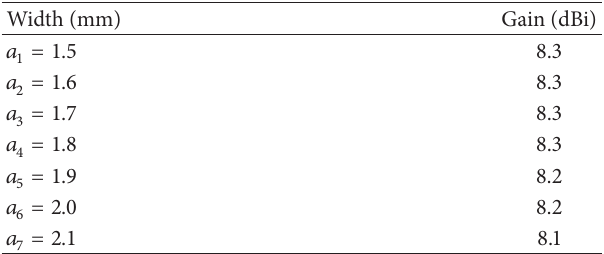
Table 3: Antenna gain line analysis.